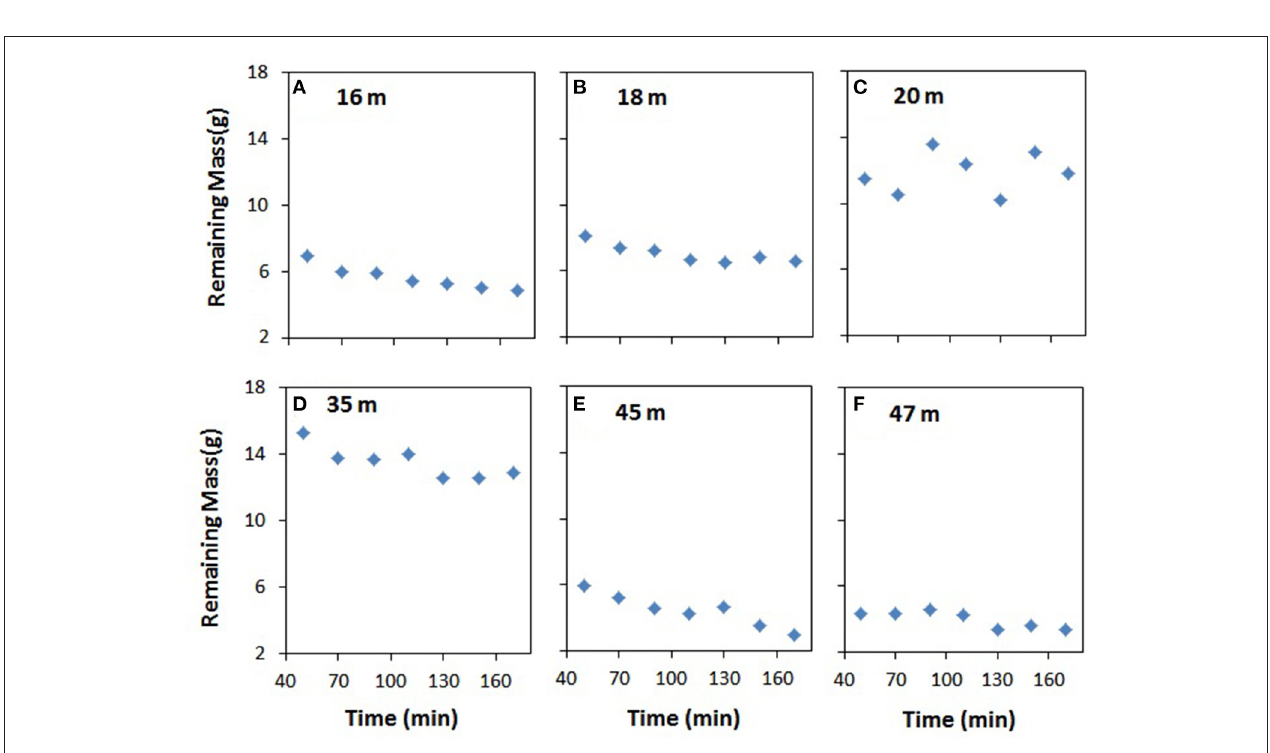
FIGURE 7 | Remaining mass of salt in the wellbore as a function of time for the NUC well near the identified peaks at: (A) 16m, (B) 18m, (C) 20m, (D) 35m, (E) 45m, and (F) 47m.